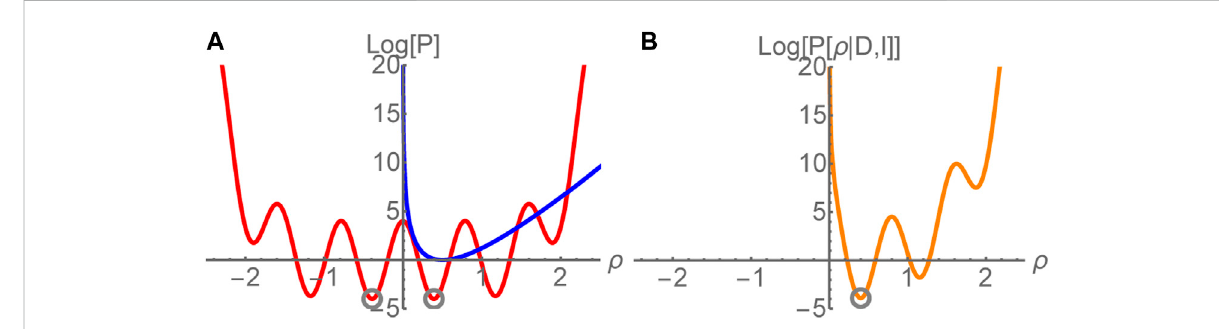
FIGURE 3 Sketch of how the con fl uence of (A) likelihood (red) and (a convex) prior (blue) in the posterior [orange, (B) ] leads to a regularization of the inverse problem. Instead of multiple degenerate minima in the likelihood (gray circles) only a single unique one remains in the